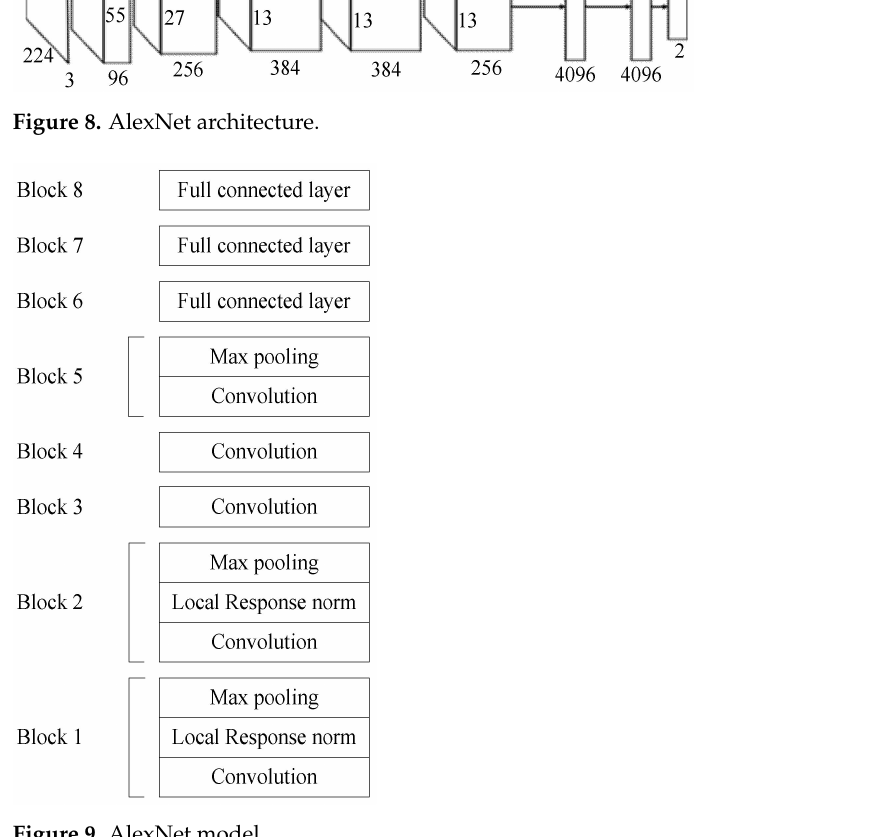
Figure 9. AlexNet